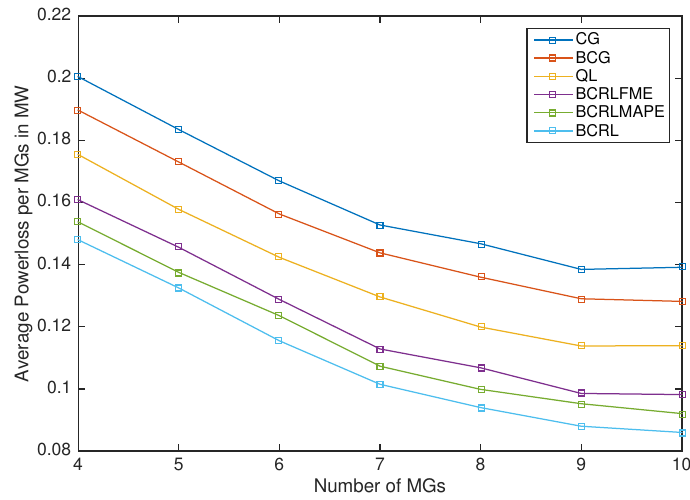
Figure 4. Average power loss versus number of microgrids.